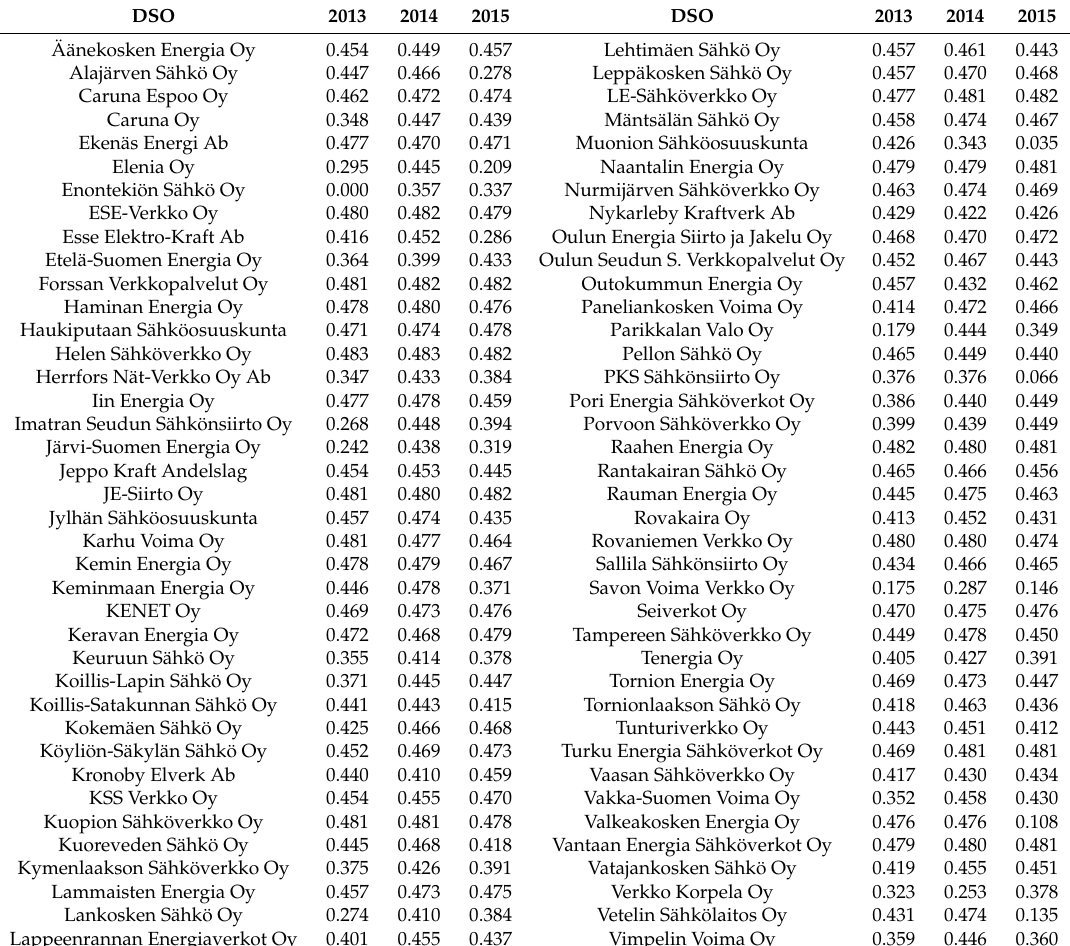
Table A1. Shadow prices of one minute of interruption ( € cents),